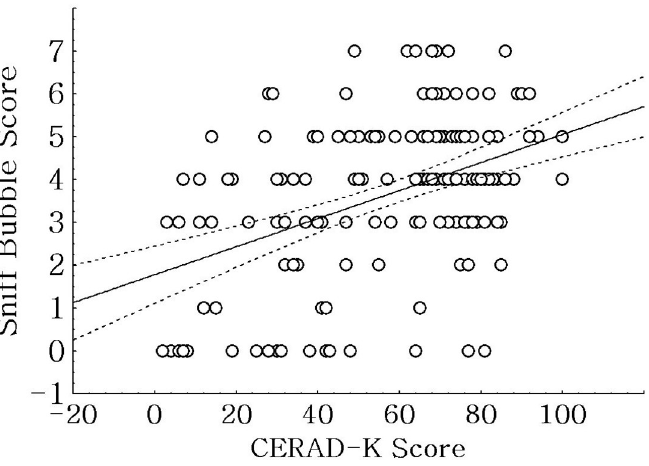
Fig 3. Analysis of the correlation between the Sniff Bubble and the neurocognitive test scores. There was a positive correlation between the Sniff Bubble and the Korean version of the Consortium to Establish a Registry for Alzheimer’s Disease assessment packet (CERAD-K) scores ( r = 0.431, p < 0.001). https://doi.org/10.1371/journal.pone.0254357.g003 3.108. After K-means cluster analysis, we allocated the 162 participants into the Normal (100) and Cog-D groups (62).